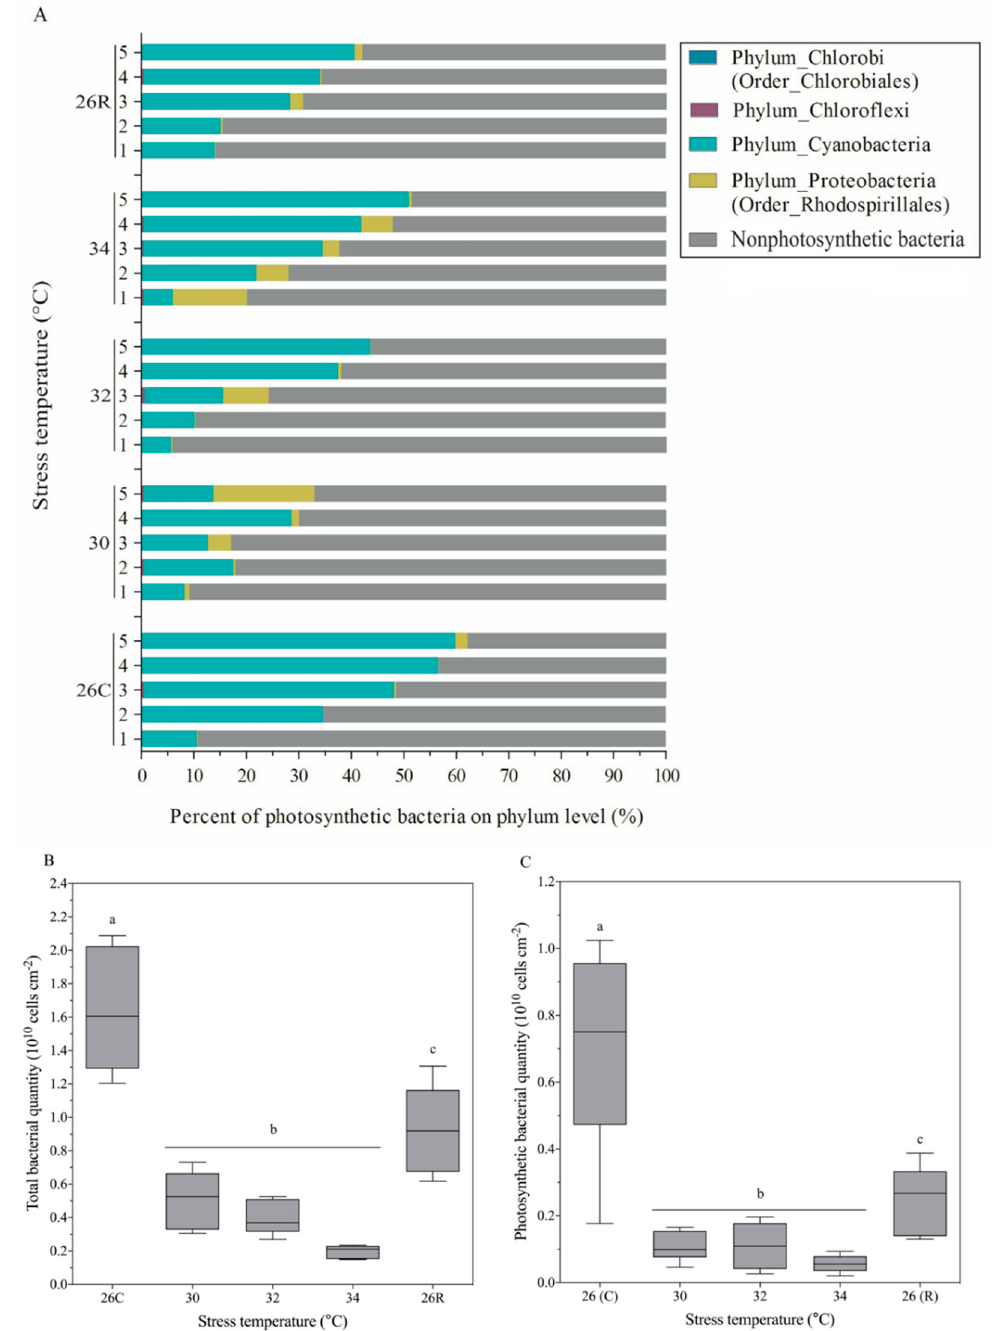
Figure 6. Changes in bacterial community composition and absolute numbers in the coral Pocillopora sp. at different temperatures: ( A ) shows the relative abundance of photosynthetic bacteria at the phylum level; ( B , C ) show the absolute numbers of total bacteria and photosynthetic bacteria, respectively, in 90 mg of coral. The data in ( B , C ) are the means ± SEs. The coordinates 26C and 26R represent the 26 ◦ C control and 26 ◦ C recovery, respectively. Five biological samples ( n = 5) were collected at the last moment of each temperature gradient for bacterial composition and quantification determination. Six replicates of the bacterial quantification data were obtained for each sample. The data were subjected to nonparametric Kruskal–Wallis tests (same letters: no significant difference; different letters: significant difference, p < 0.05).